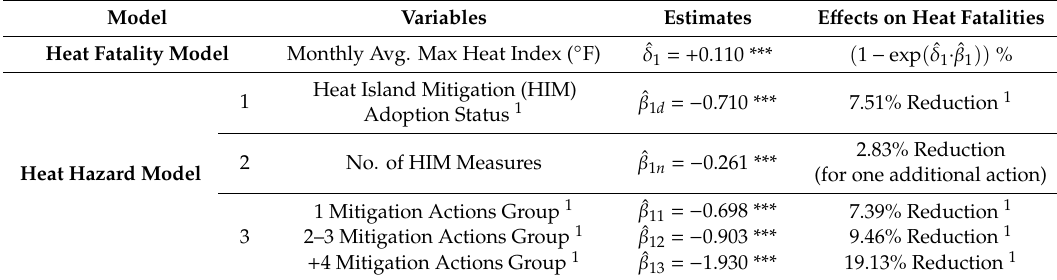
Table 9. The mediated e ff ect of heat mitigation measures on heat